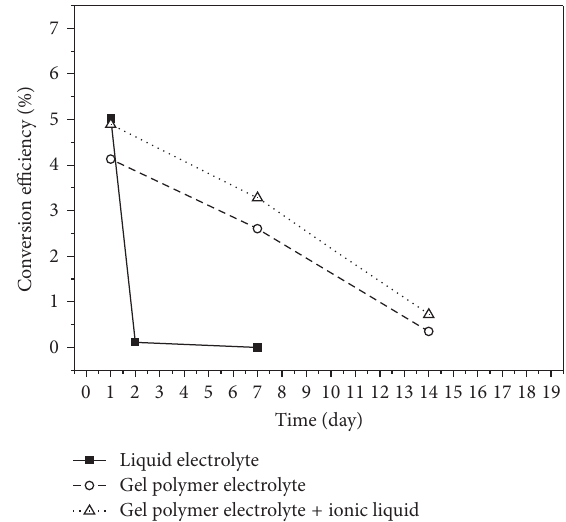
F 6: Photovoltaic curves ( J - V ) of the DSSC based on the composite electrolytes with 1-butyl-3-methyl-imidazolium tetra�u- oroborate at different molalities.